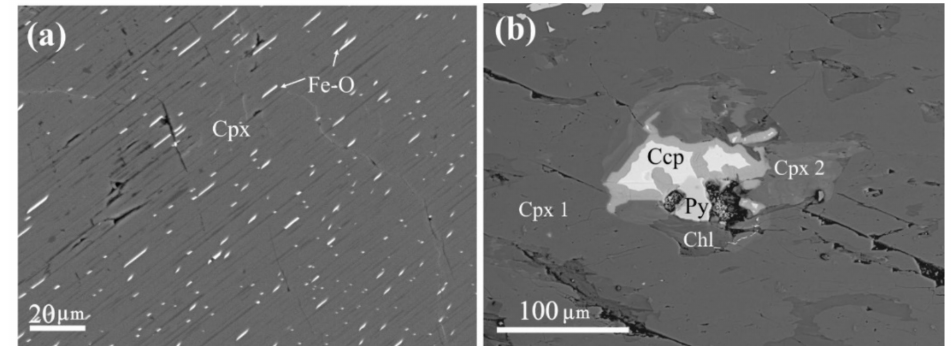
Figure 4. Clinopyroxene in samples of clinopyroxenites III ( a ) and I ( b ). ( a ) Thin plates of Fe-O phase in primary clinopyroxene (Cpx); ( b ) secondary clinopyroxene (Cpx 2) in intergrowths with chlorite (Chl), pyrite (Py), and chalcopyrite (Ccp) in primary clinopyroxene (Cpx